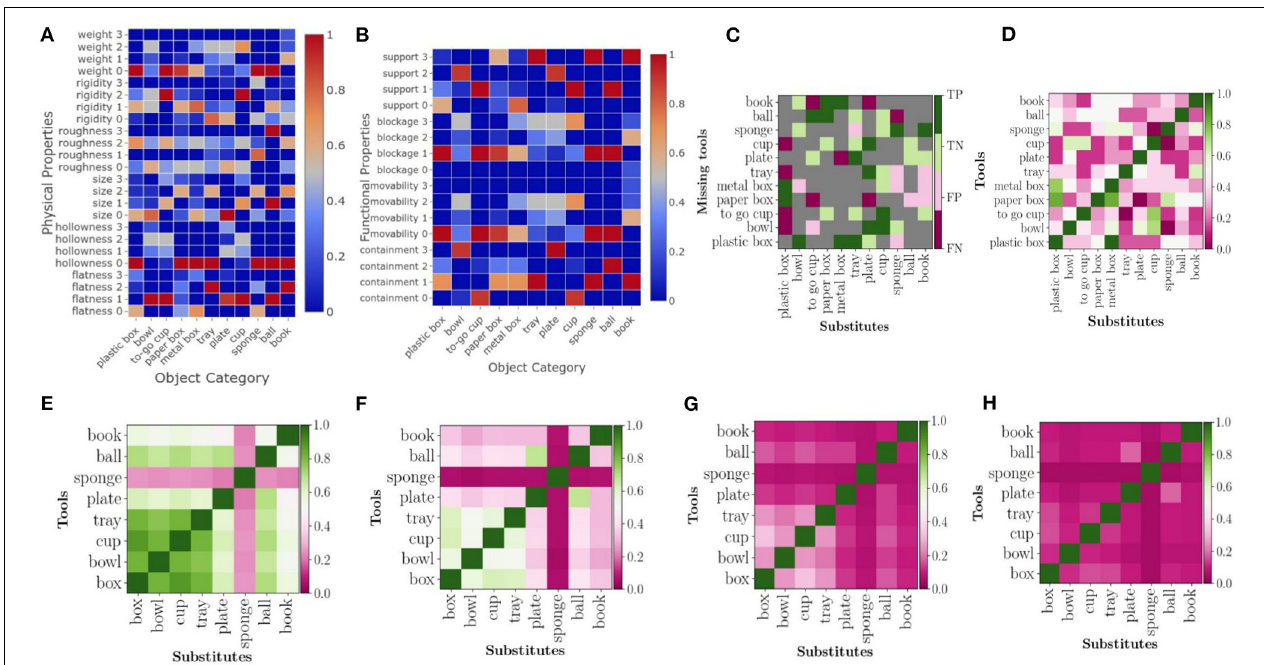
FIGURE 12 | (A) Qualitative knowledge about physical properties; (B) Qualitative knowledge about functional properties; (C) The distribution of true positives (TP), true negatives (TN), false positives (FP), and false negatives (FN) in each substitution scenario; (D) Similarity between a tool and a substitute using Jaccard’s Index; (E) Wu-Palmer similarity; (F) Lin Similarity; (G) Path similarity; (H) Jiang-Conrath